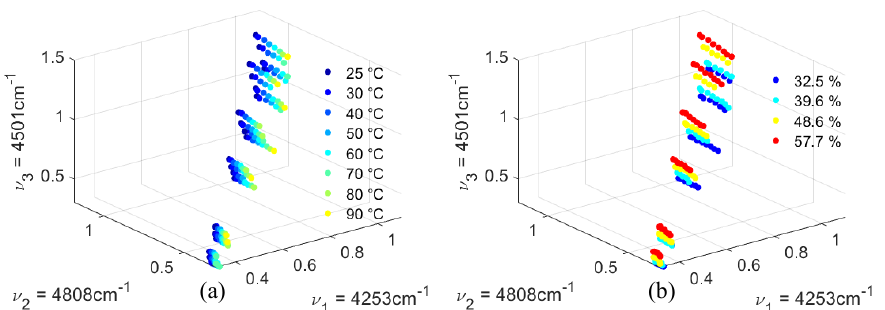
Figure 6. Three-dimensional scatter plot in 𝜈 1 - 𝜈 2 - 𝜈 3 space of absorbance data from the calibration set at the respective wavenumbers 𝜈 1 , 𝜈 2 and 𝜈 3 . ( a ) Dots are color coded with respect to film temperature. ( b ) Dots are color coded with respect to urea concentration.